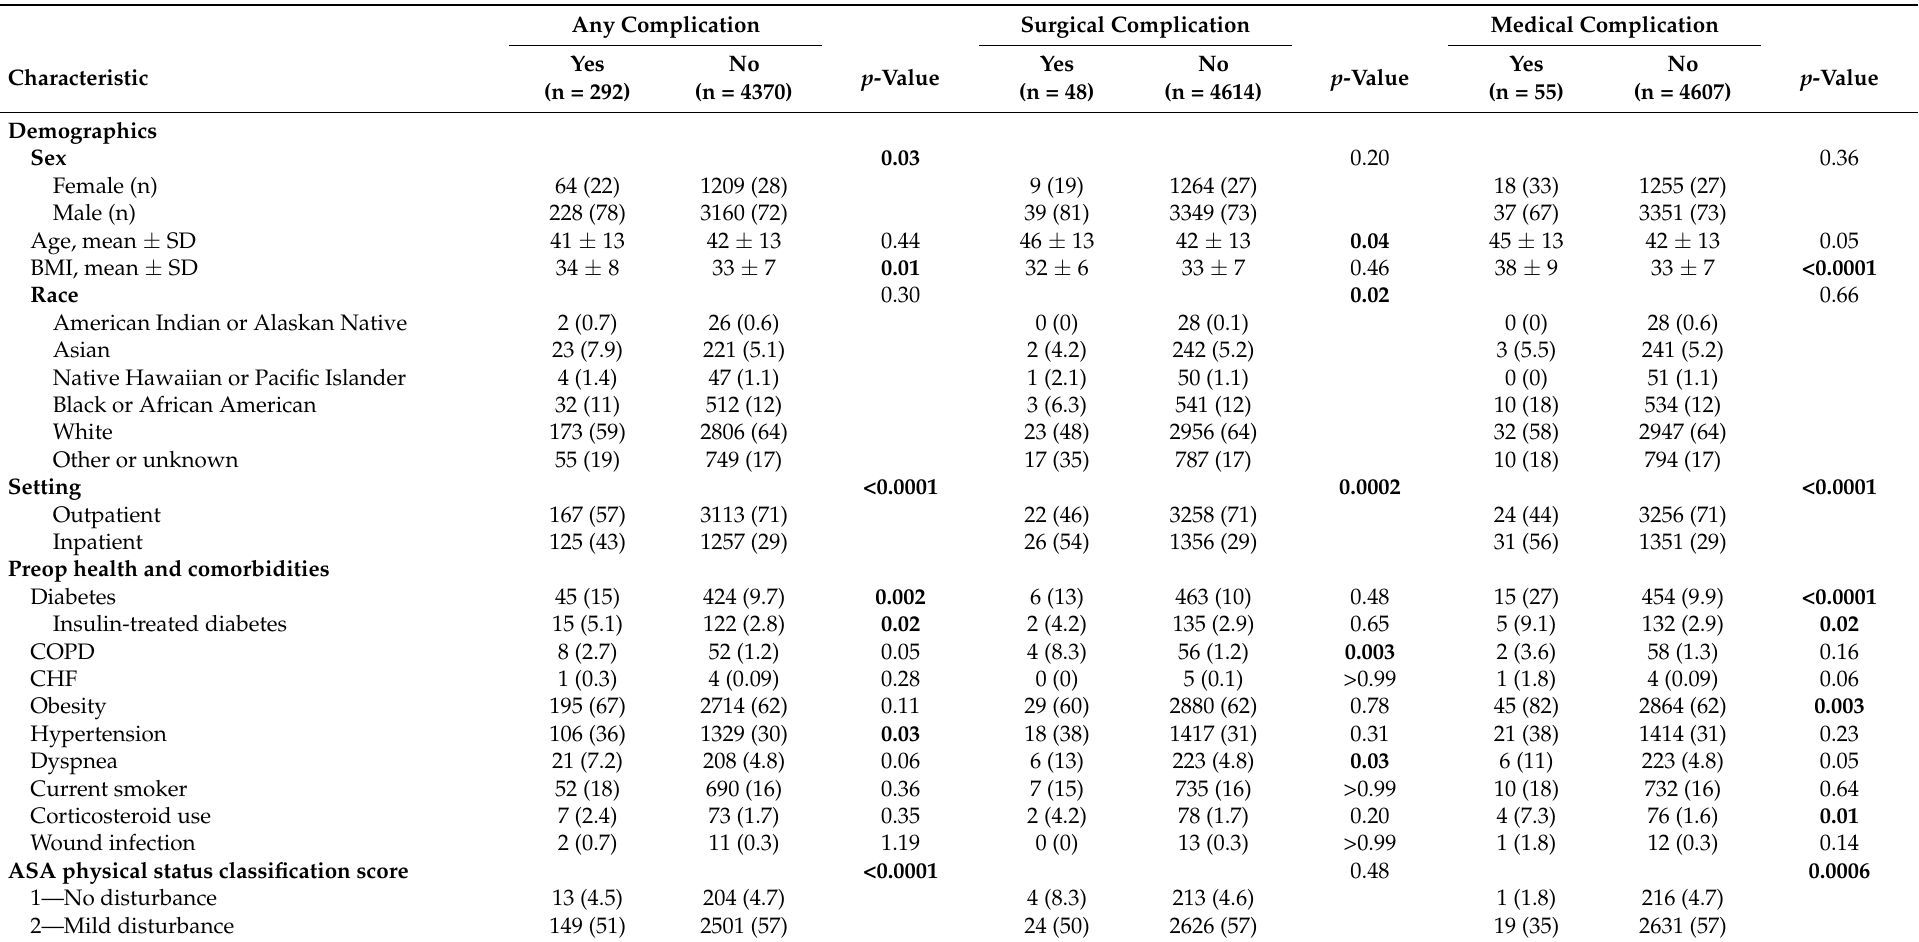
Table 6. Risk-associated factors for complications. Reported as n (%), unless otherwise stated. Statistically significant p -values are highlighted in